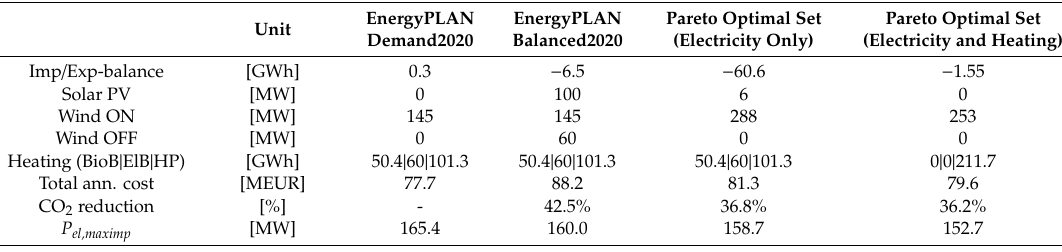
Table 5. Selected results approximating near-zero electricity import / export-balance. EnergyPLAN EnergyPLAN Pareto Optimal Set Pareto Optimal Set Unit Demand2020 Balanced2020 (Electricity Only) (Electricity and Heating) Imp / Exp-balance [GWh] 0.3 −